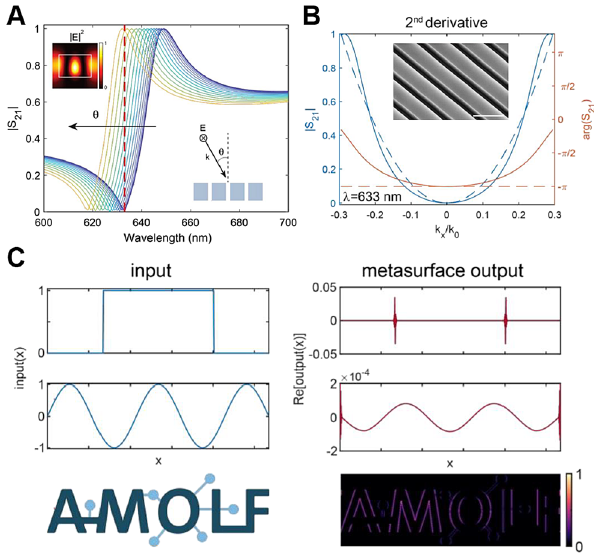
Figure 14: Optical computing based on Fano-resonant metasurface [49]. (A) Simulated transmission spectra of a metasurface consisting of an array of dielectric nanobeams as the incident angle is changed from 0 (blue line) to 0.3 rad (yellow line) in 15 steps. The red dashed line indicates the wavelength of operation (633 nm). (B) Transmission amplitude (solid blue line) and phase (solid orange line) for the metasurfaceoptimizedforsecond-derivativeoperation(sketchedinthe inset) at 633 nm. The simulated transfer function is compared to the ideal case (dashed lines). The transmission reference plane is set such that the transmission phase at normal incidence equals − π . (C) Rectangularandsinusoidalinputfunctionsand2Dimagethatareused to numerically test the metasurface operation. The signal is discretized into 1000 pixels with individual pixel size set such that the Nyquist rangematchestheoperationalrangein k -spaceofthemetasurface(left column). Metasurface output for the input in part b. For the 2D image, differentiation is performed line by line along the x -axis (right